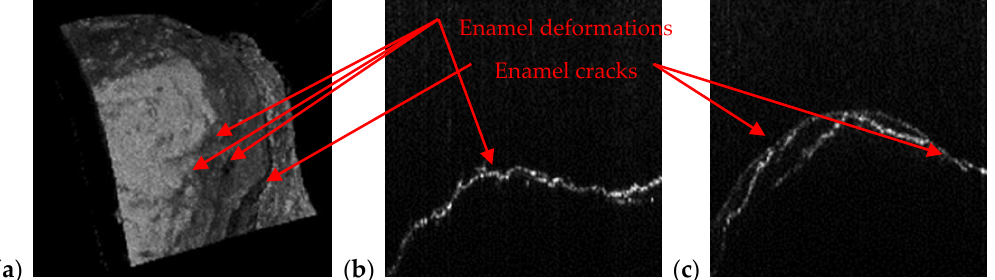
Figure 12. Enamel deformations and cracks of an incisive tooth observed on ( a ) OCT 3D reconstruction, as well as on ( b , c ) different B-scans.